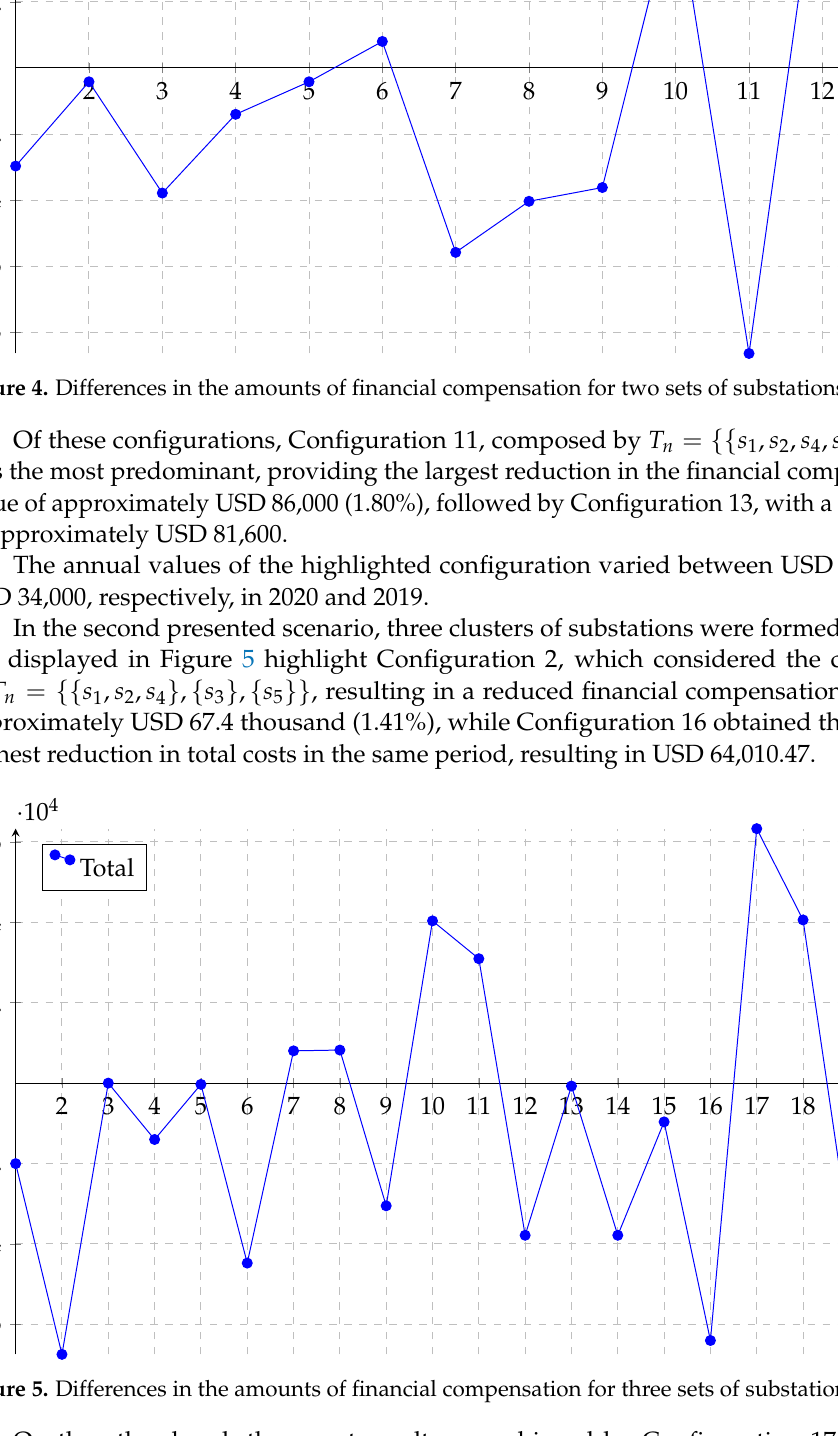
2019 benefited the most, presenting a reduction of USD 24,000 with Configuration